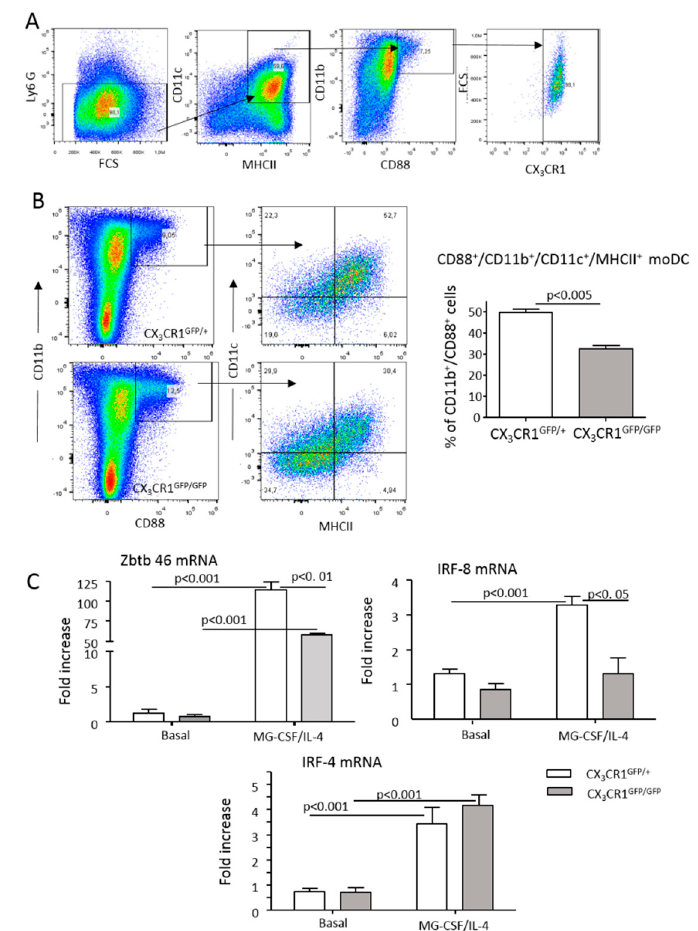
Figure 5. A lack of CX 3 CR1 affects the in vitro differentiation of monocyte-derived dendritic cells (moDCs). MoDCs were obtained in vitro by a seven-day culture of bone marrow myeloid cells from either CX 3 CR1 gfp/+ or CX 3 CR1 gfp/gfp mice with granulocyte-macrophage colony stimulating factor (GM-CSF) and interleukin-4 (IL-4). ( A ) CX 3 CR1 expression in Ly6G - /CD11b + /CD88 + /CD11c + /MHCII high moDC originating from GM-CF/IL-4-treated bone marrow myeloid cells. ( B ) The effect of CX 3 CR1 on the in vitro differentiation of CD11b + /CD88 + /CD11c + /MHCII high moDCs. ( C ) Effect of CX 3 CR1 on the expression of the transcription factors Zbtb46, IRF-4 and IRF-8 implicated in moDC differentiation. The values are expressed as means ± SD of 3–5 different cell preparations.